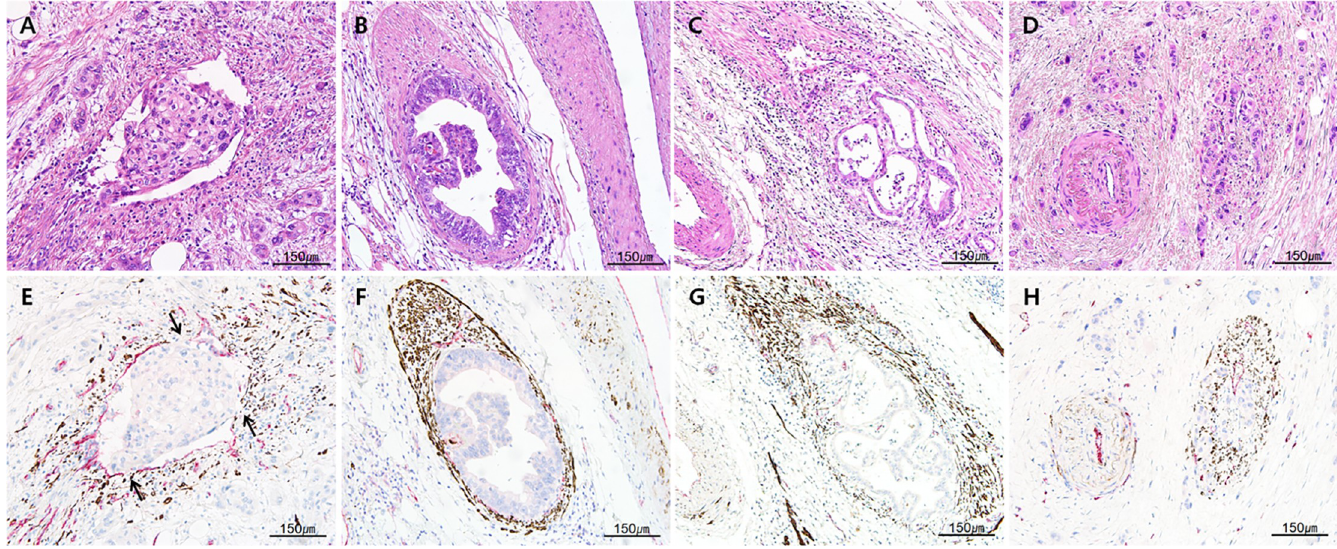
Fig 3. Representative H&E staining and dual CD31–desmin immunolabeling (magenta, CD31; desmin, brown) images of different patterns of venous invasion of pancreatobiliary tract cancers. A and E) Conventional pattern. Cancer cells within venous space partly attach to endothelial cells showing partial loss of CD31 expression (arrows), while cancer cell-non-attached endothelial cells show magenta color (intact CD31 labeling); B and F) IN-like pattern; cancer cells within venous space show spotty CD31 expression (magenta color) with well- circumscribe outer desmin-positive (brown color) smooth muscle layer; C and G) definite destructive pattern of venous invasion on H&E staining (C) . Some parts of smooth muscular layer are destroyed by infiltrating cancer cells and remnant smooth muscle layer of muscular vein is identified on the H&E-stained ( C ) and confirmed by desmin ( G ; brown color) immunolabeled slide; D and H) suspicious destructive pattern of venous invasion on H&E staining ( D ). The single artery sign is observed; however, almost all smooth muscular layer are destroyed by infiltrating cancer cells and the equivocally remnant smooth muscle layer of muscular vein cannot be definitely identified on the H&E-stained slide ( D ) but is confirmed by the desmin ( H ; brown